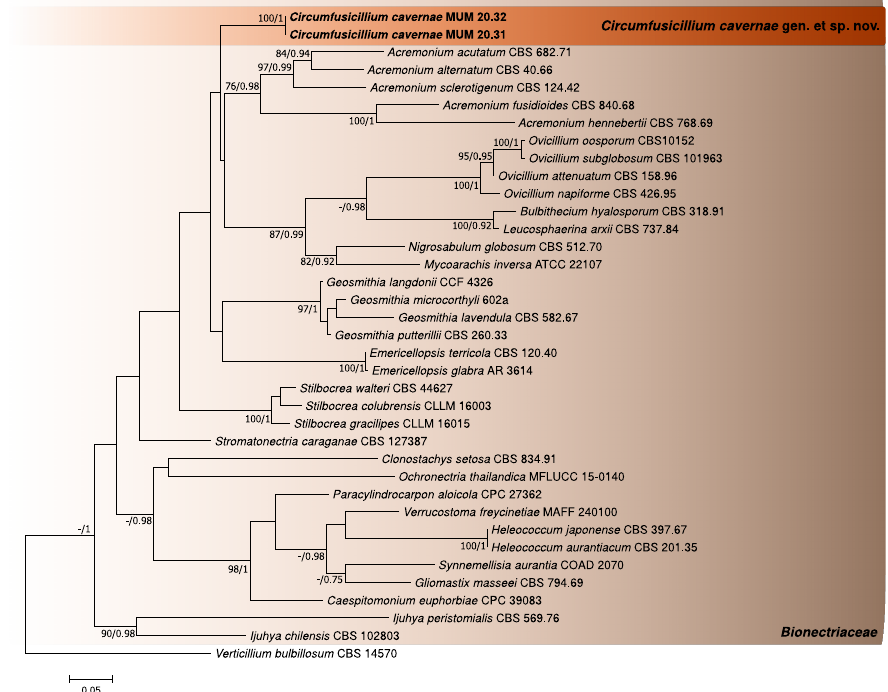
Figure 2. Phylogenetic trees obtained using reference Bionectriaceae ITS sequences. The new taxa are indicated in black and bold . The scale bar indicates the number of substitutions per site, and the support values (>75% bootstrap values for Maximum likelihood and >0.75 for Bayesian MCMC posterior probabilities) are also